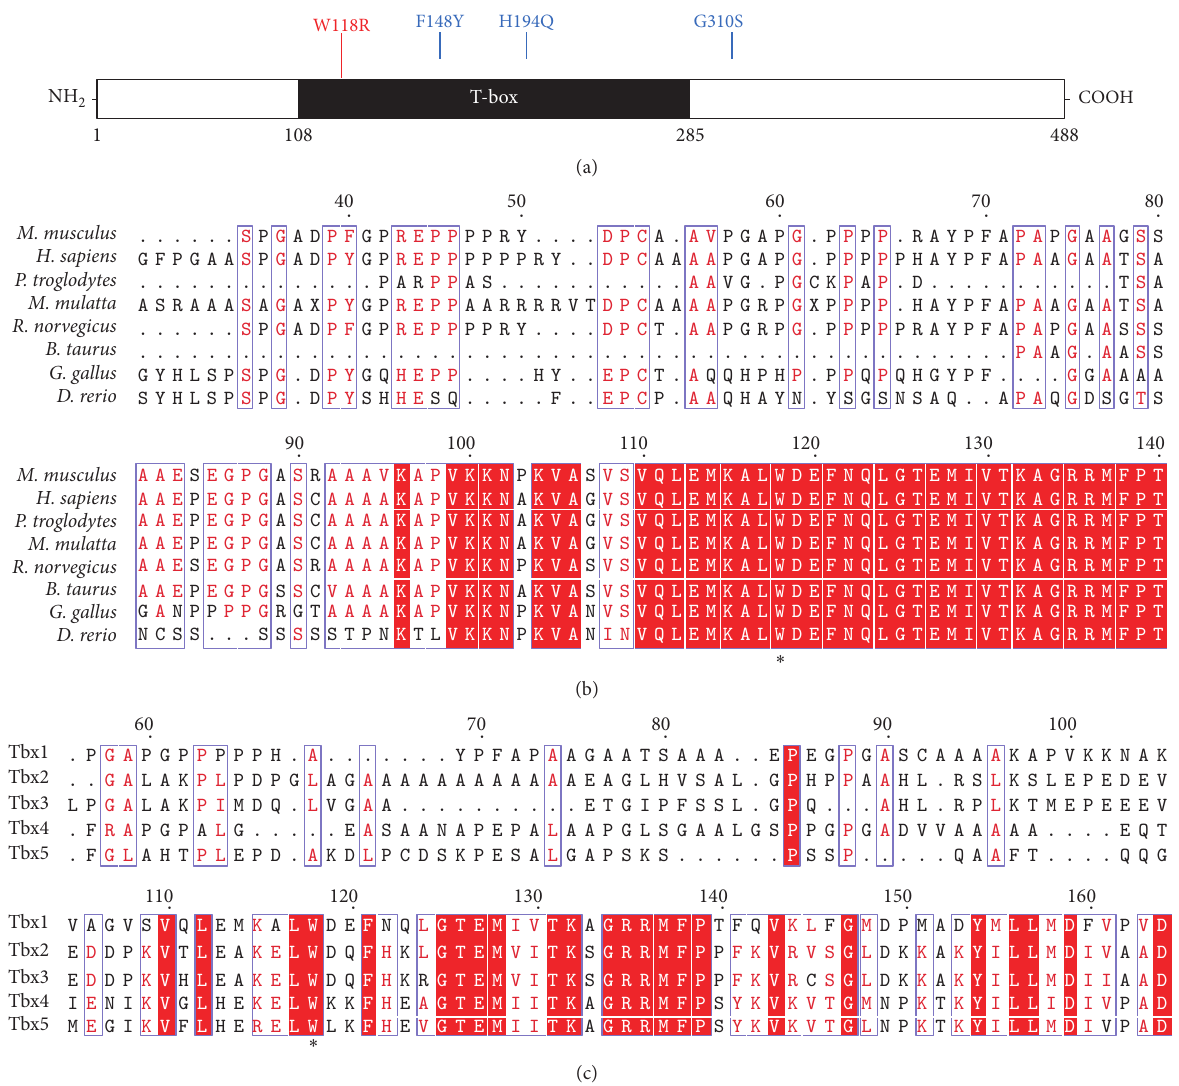
Figure5:ConservationanalysisofnonsynonymousmutationinTBX1foundinthe ENU706 mutantmouse.(a)The ENU706 mutationcaused a W118R conversion. F148Y, H194Q, and G310S mutations, previously reported in DGS patients, are also indicated [24]. (b) The W118 is highly conserved across the species. The protein NCBI IDs, NP 035662.1 ( M. musculus ), NP 542377.1 ( H. sapiens ), XP 016795078.1 ( P. troglodytes ), XP 015005141.1 ( M. mulatta ), NP 001101792.1 ( R. norvegicus ), XP 002694701.2 ( B. taurus ), XP 015131167.1 ( G. gallus ), and NP 899182.1 ( D. rerio ). (c) The Trp amino acid is also highly conserved in 5 TBX paralogues. The protein NCBI IDs, NP 542377.1 (Tbx1), NP 005985.3 (Tbx2), NP 005987.3 (Tbx3), NP 001308049.1 (Tbx4), and NP 000183.2 (Tbx5). ∗ refers to the W118 in (b) and Trp amino acid in